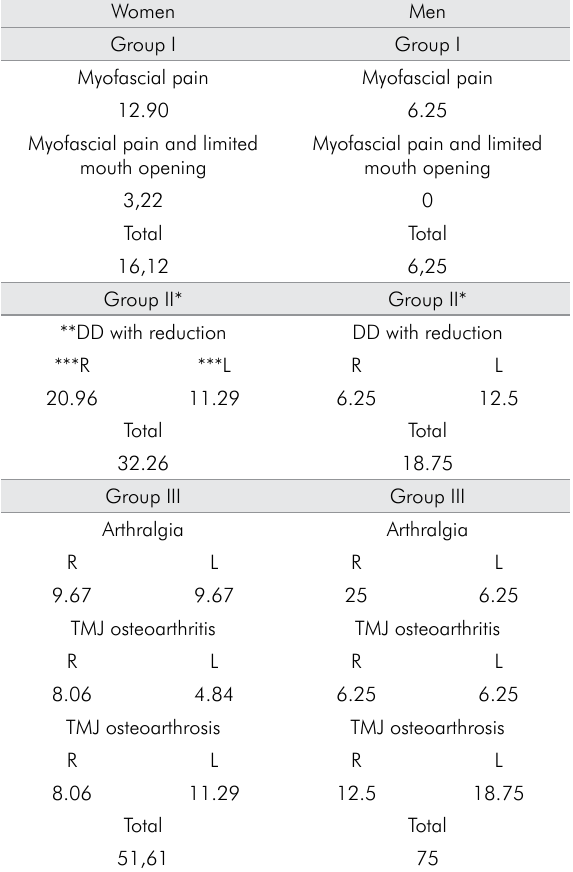
Table 2. Distribution of the number of women with (+) or without (-) TMD and head tilt.